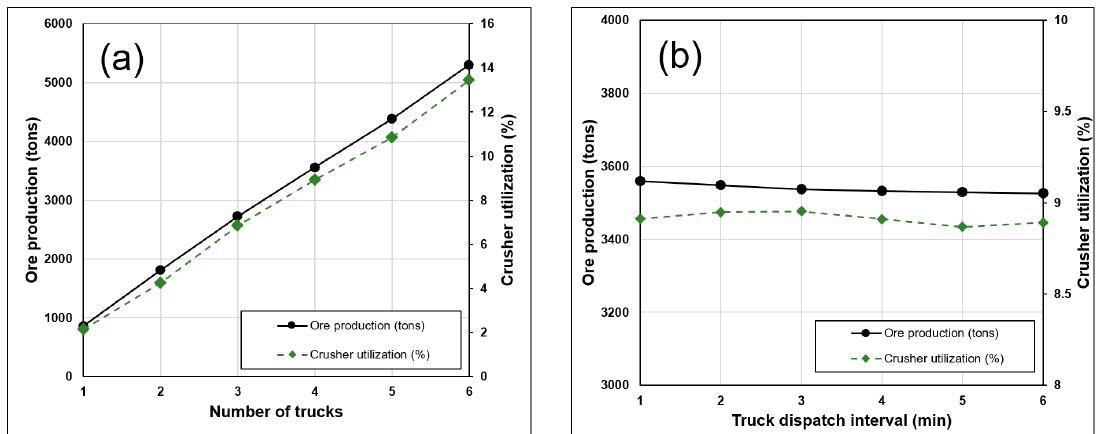
Figure 13. Results of analyzing variations in ore production and crusher utilization according to: ( a ) number of trucks and ( b ) truck dispatch interval (min).